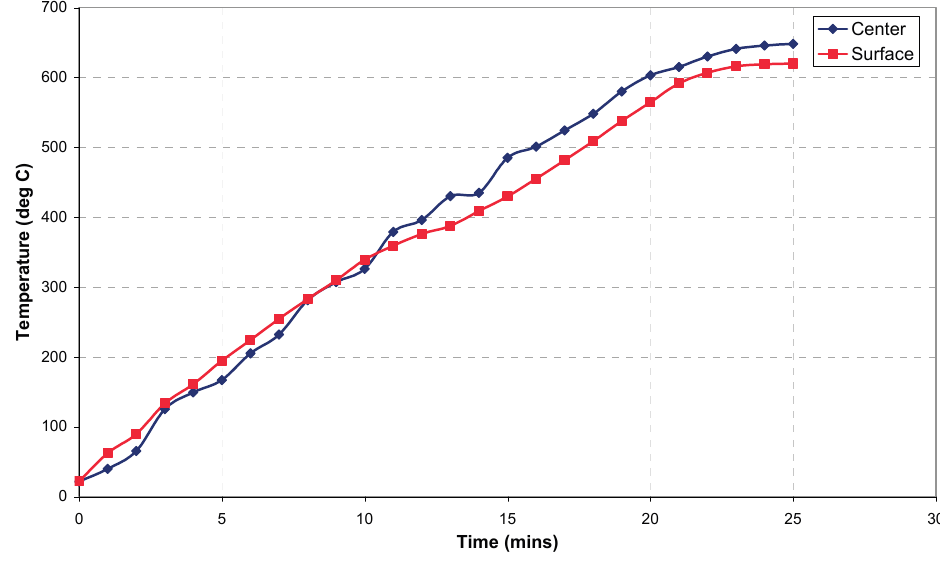
Figure 3. In-situ temperature measurements in the center and on the surface of an aluminum compact